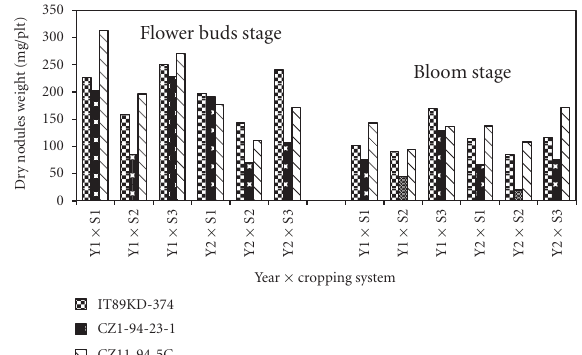
Figure 2: Nodules dry weight (mg/plant) as a ff ected by year × cropping system × cowpea variety interactions e ff ects ( P < 0 . 01) at flower buds and bloom stage at Cinzana Agronomic Research Station, 2007 and 2008. Y1: year 1 (2007); Y2: year 2 (2008), S1: alternate rows intercropping (1 row millet/1 row cowpea), S2: inter hills intercropping (2 hills millet/1 hill cowpea), S3: cowpea sole crop, cowpea varieties: IT89KD-374, CZ1-94-23-1, and